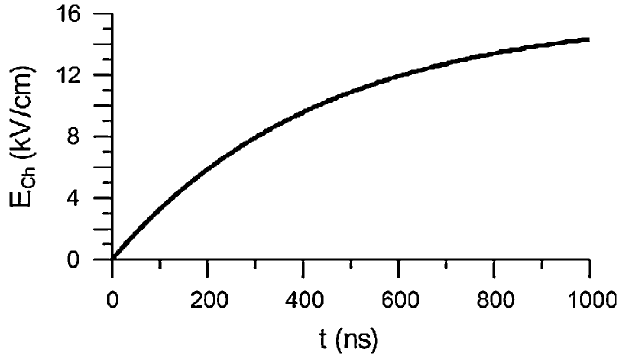
FIG. 12. Time behavior of the maximum amplitude of the electric field in a grating groove in the energy storage regime in the resonator for the incident power P inc ¼ 250 kW .